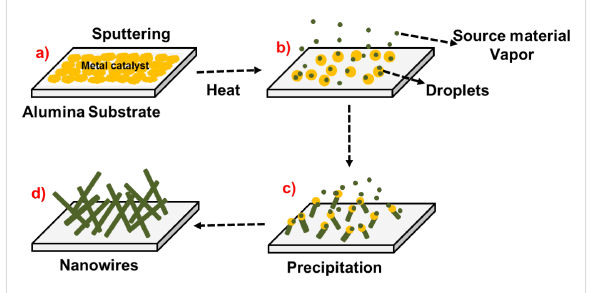
Figure 14: Growth of 1D structures by